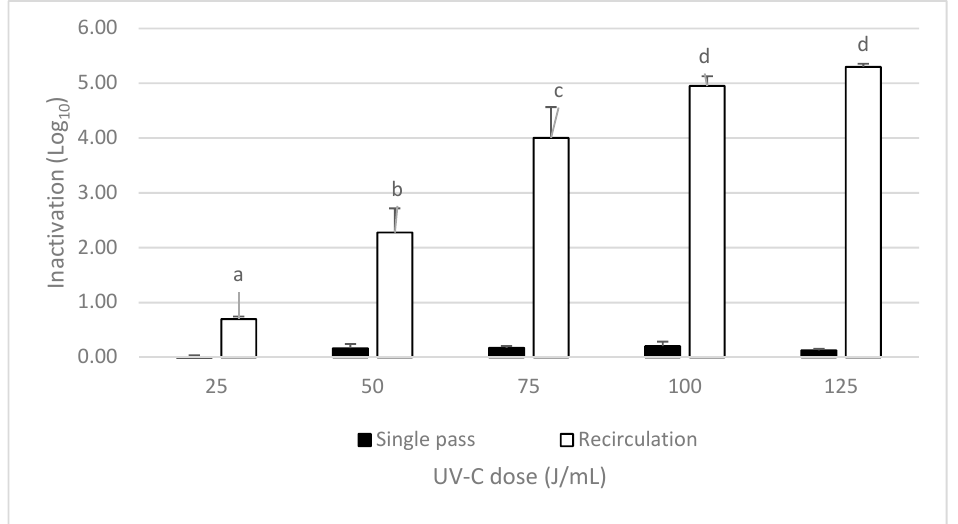
Figure 2. Inactivation of A. acidoterrestris inoculated in cloudy apple juice with ascorbic acid by UV-C at different doses (25, 50, 75, 100, and 125 J/mL) in a single pass (black bars) or in recirculation (white bars). Error bars mark the standard deviation, and letters represent significant differences ( p < 0.05) between sample means of the same treatment. No letters mean that there were no significant differences found between doses.